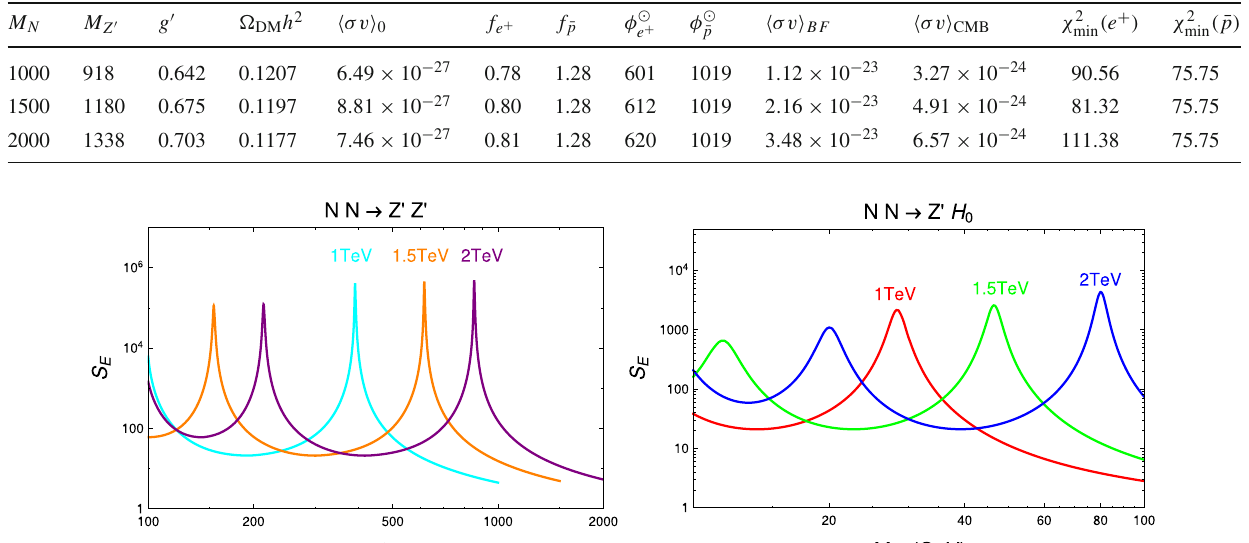
section in the Galactic halo which required by interpreting AMS-02 positron excess, and (cid:12) σv (cid:13) CMB the annihilation cross section limited by CMB observation. All of masses in units of GeV and solar modulation in units of MV